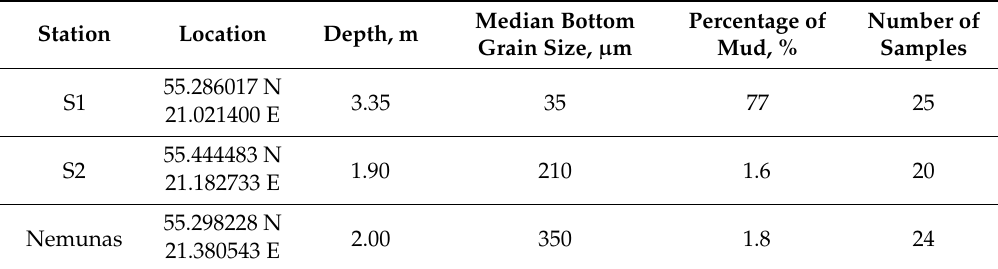
Table 1. The main characteristics of the monitoring